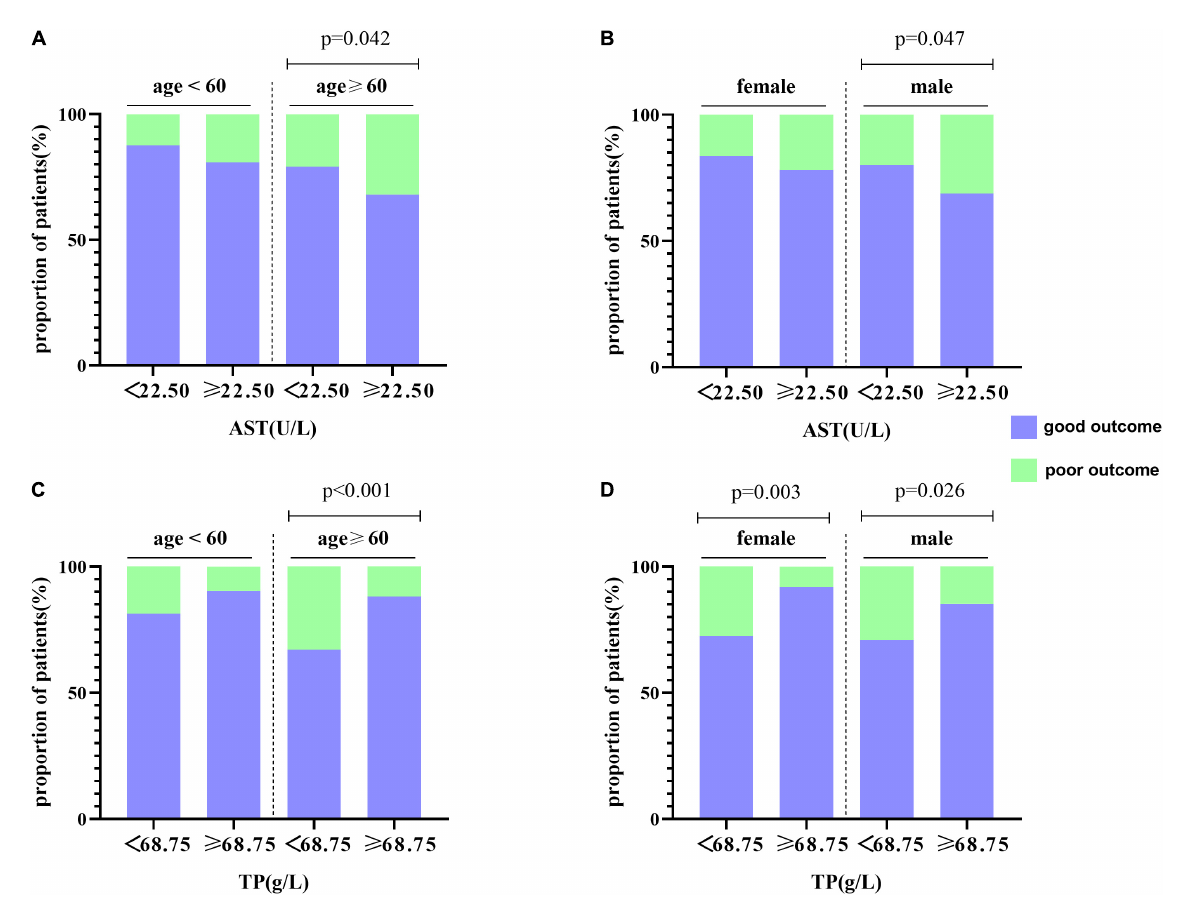
FIGURE7 Subgroup analysis for the association between AST, TP, and functional outcome at 1 year. (A,B) The distribution of AST is stratified by age and gender, respectively. (C,D) The distribution of TP is stratified by age and gender, respectively.